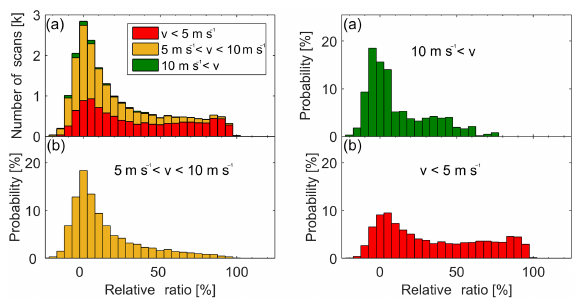
Figure 15. Histograms of the relative ratio R × 100% (see Eq. 4) between the SO 2 CDs derived by Method A and Method B for dif- ferent wind speeds at Nevado del Ruiz. The different histograms show the results for both instruments. In the top left the results for all spectra are shown. The top right shows only spectra where the wind speed was above 10ms − 1 . The results for lower wind speeds are shown in the lower part of this figure.